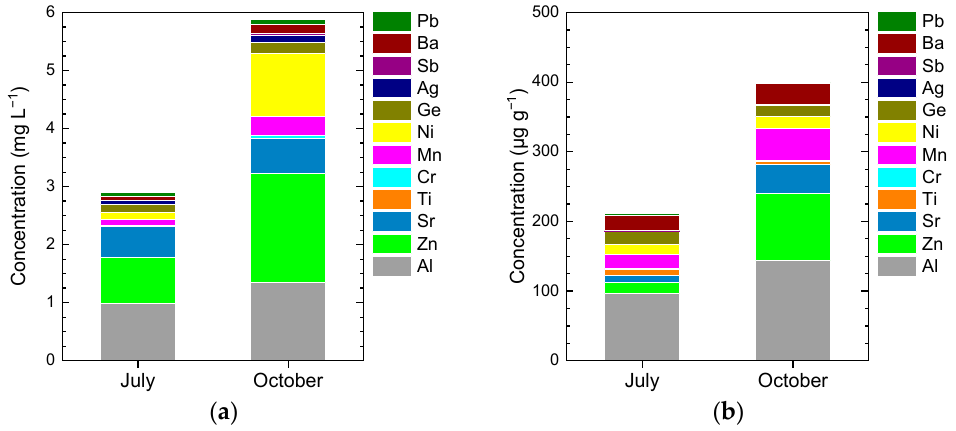
Figure 4. The cumulative concentrations of the water-soluble elements quantified in water ( a ) and sediment ( b ) samples collected from Podu Iloaiei Dam Lake in each sampling session.